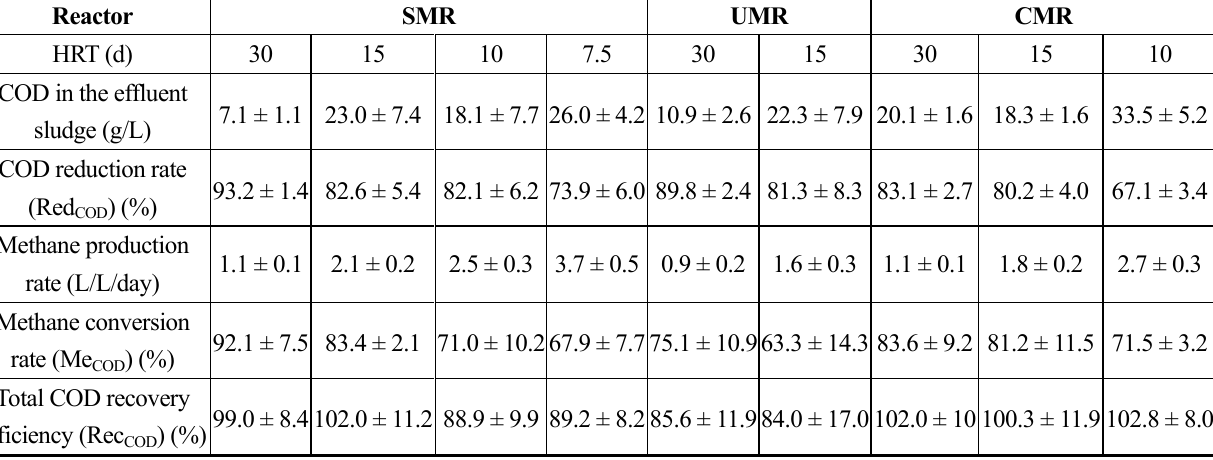
Table 1. Summary of the digestion performance of the three reactors with the different HRT conditions